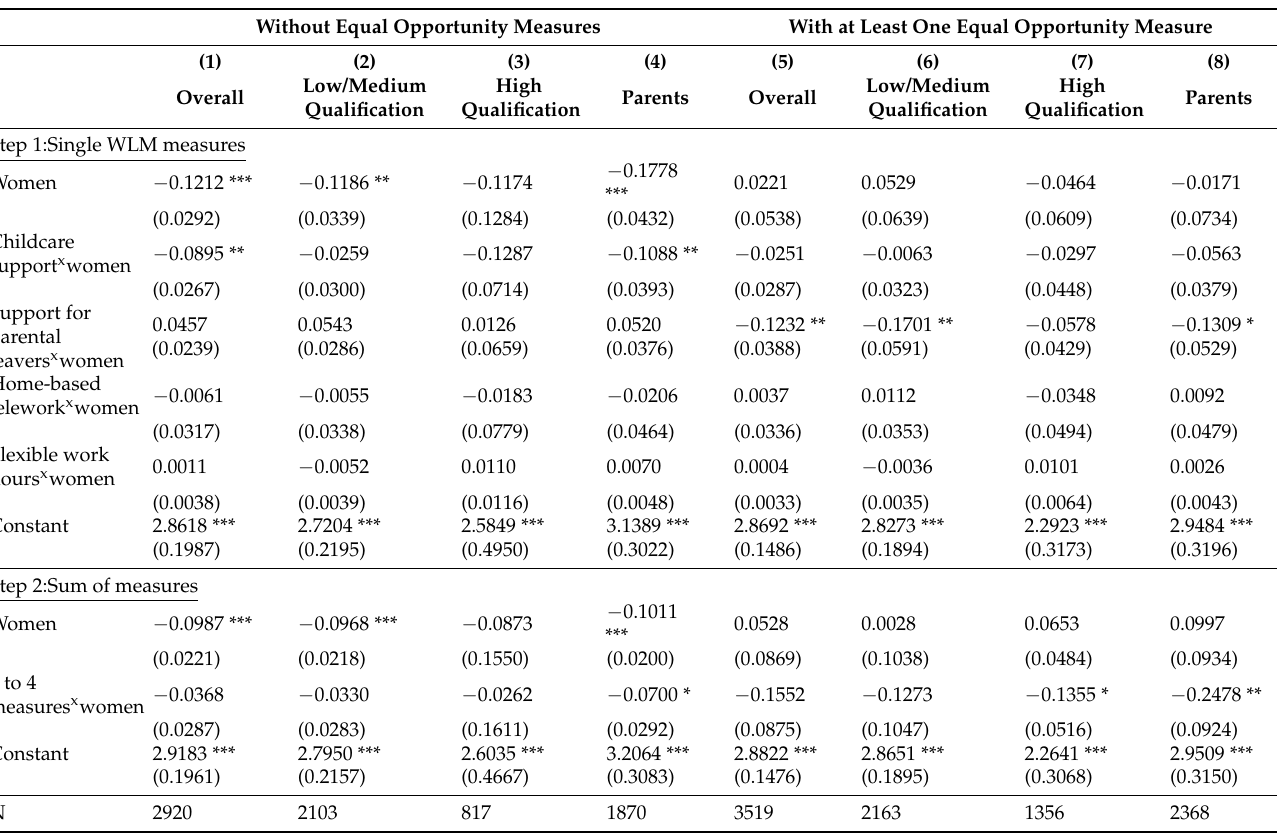
Table 5. The association of work–life measures and the log hourly wages dependent on whether organizations offer also equal opportunity measures; multi-level linear regression models with organizational fixed